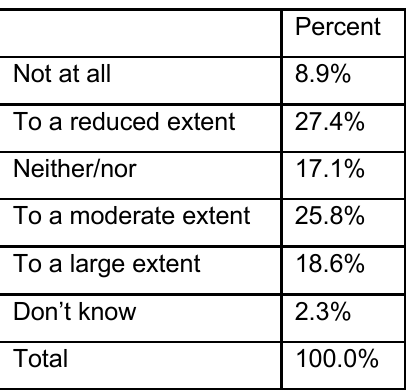
Table 6: 3rd year students’ answers to the question: ‘I have a good access to receive supervision while working on my